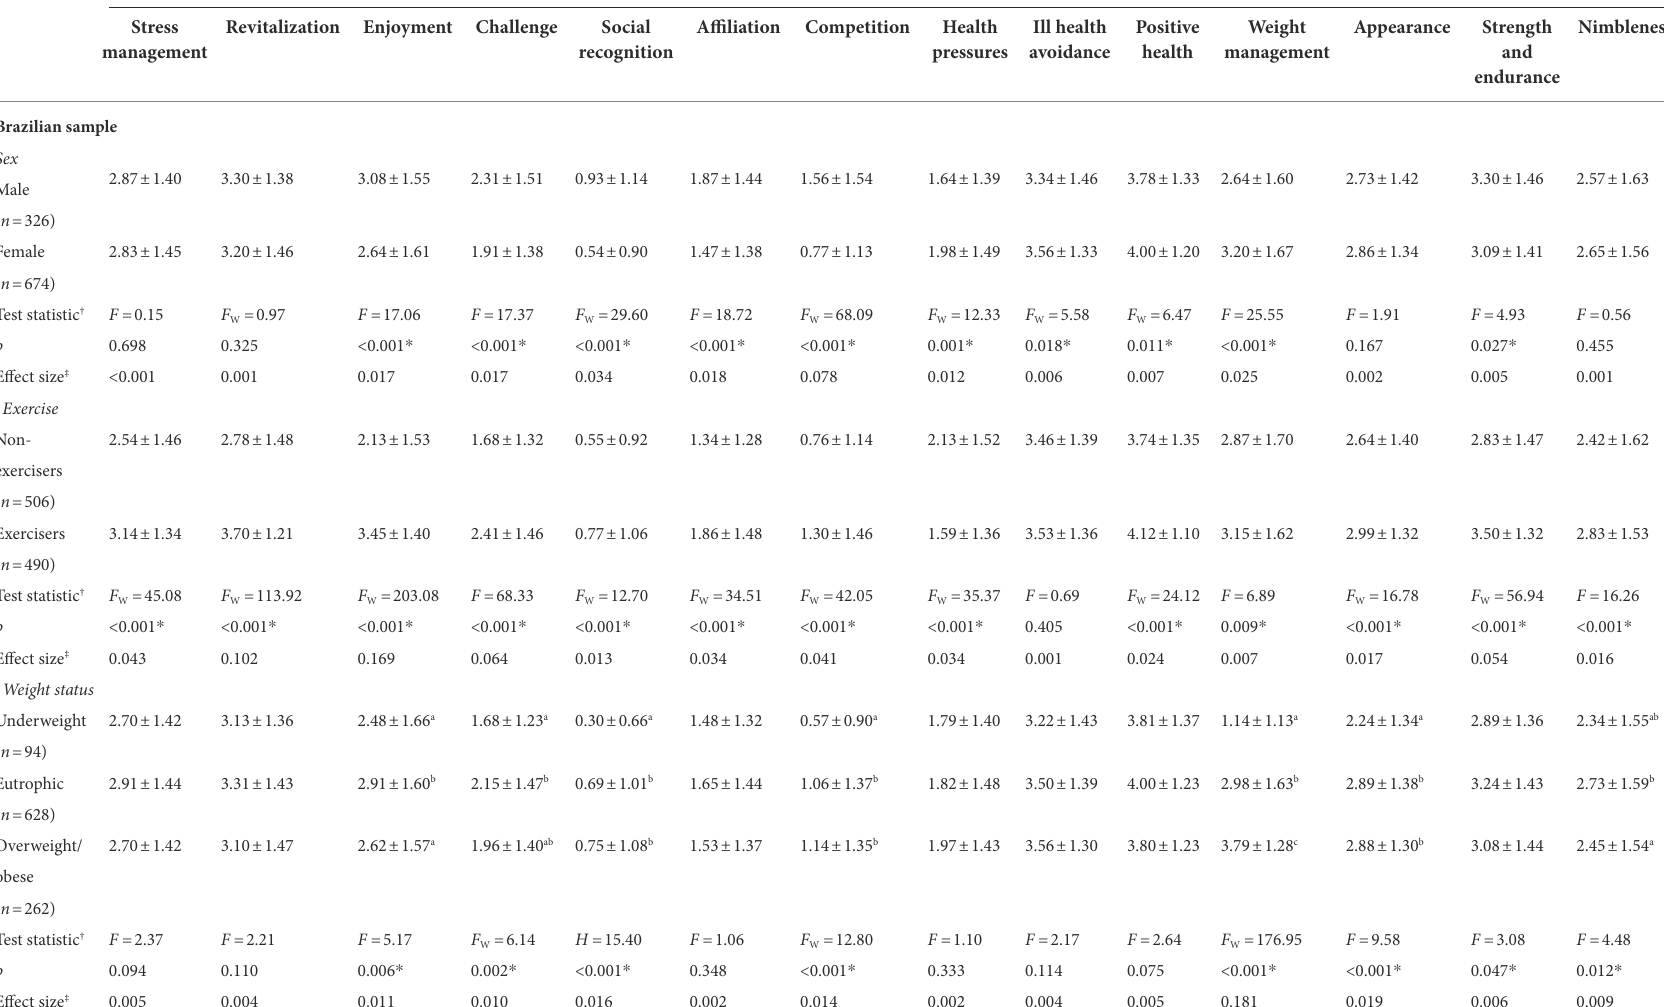
TABLE 4 Comparison of the mean scores (±standard deviation) for each factor (single-factor models) of the exercise motivations inventory-2 (EMI-2) according to sex, exercise, and weight status in the Brazilian and Portuguese